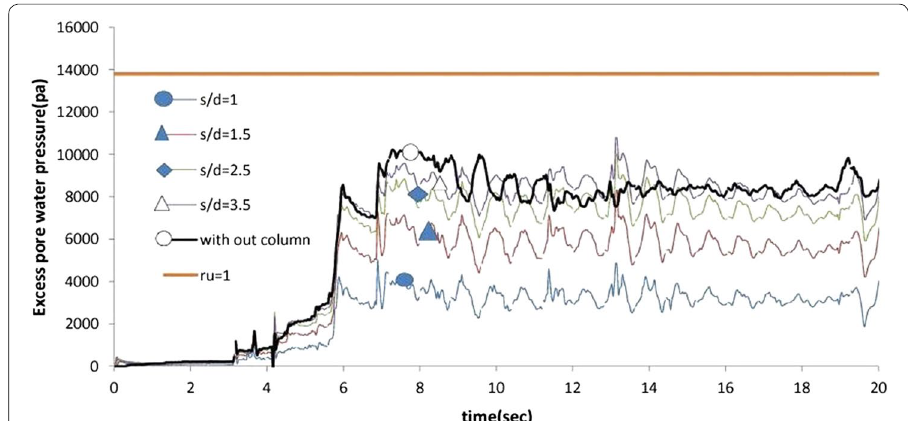
Fig. 8 Changes of excess pore water pressure at depth of 1.5 m